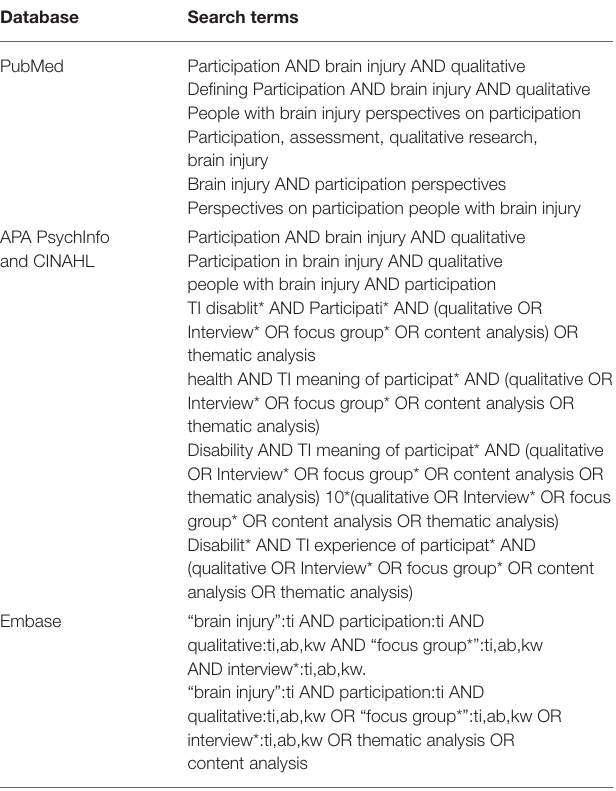
TABLE 1 | Databases and search